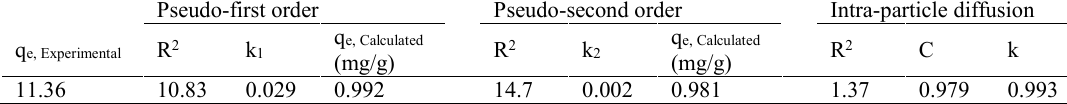
Table 2. Parameters of various kinetic models for the adsorption of lead by MBAS q e, Experimental